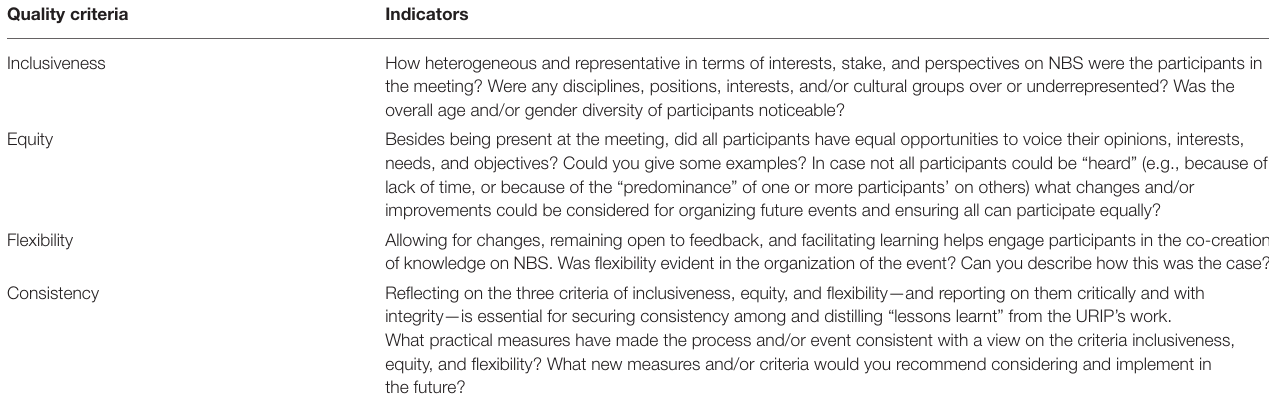
TABLE 3 | Overview of the quality criteria chosen for operationalizing the transdisciplinary research quality principles of relevance, credibility, and legitimacy. Quality